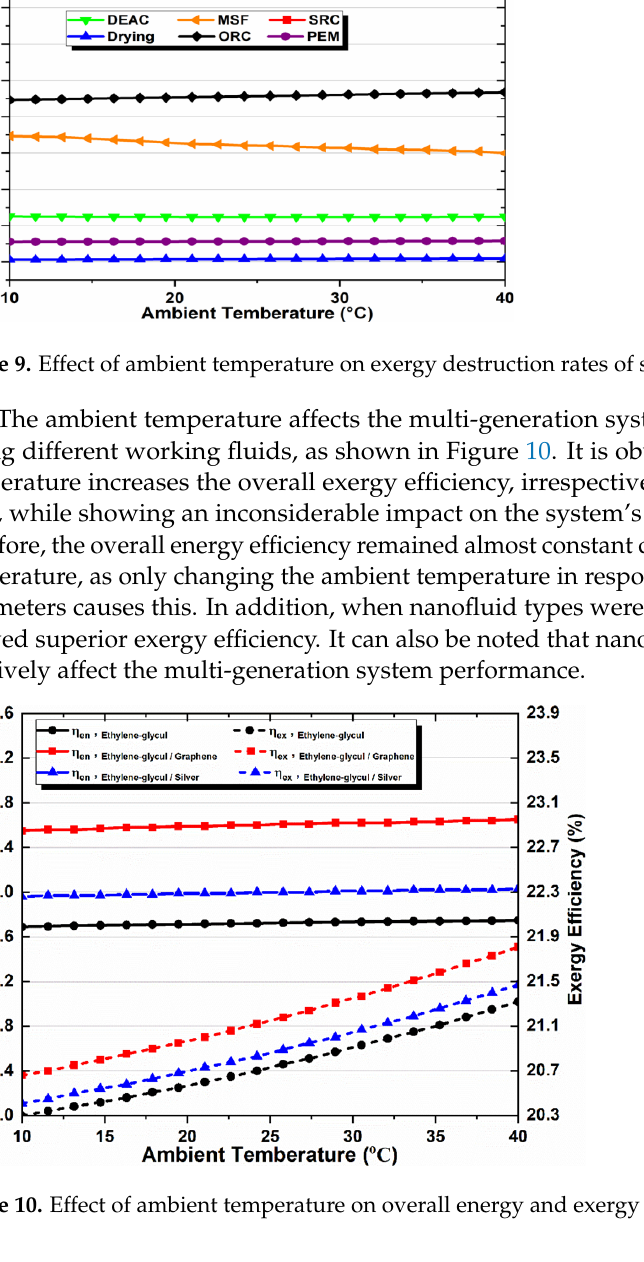
Figure 10. Effect of ambient temperature on overall energy and exergy efficiencies.